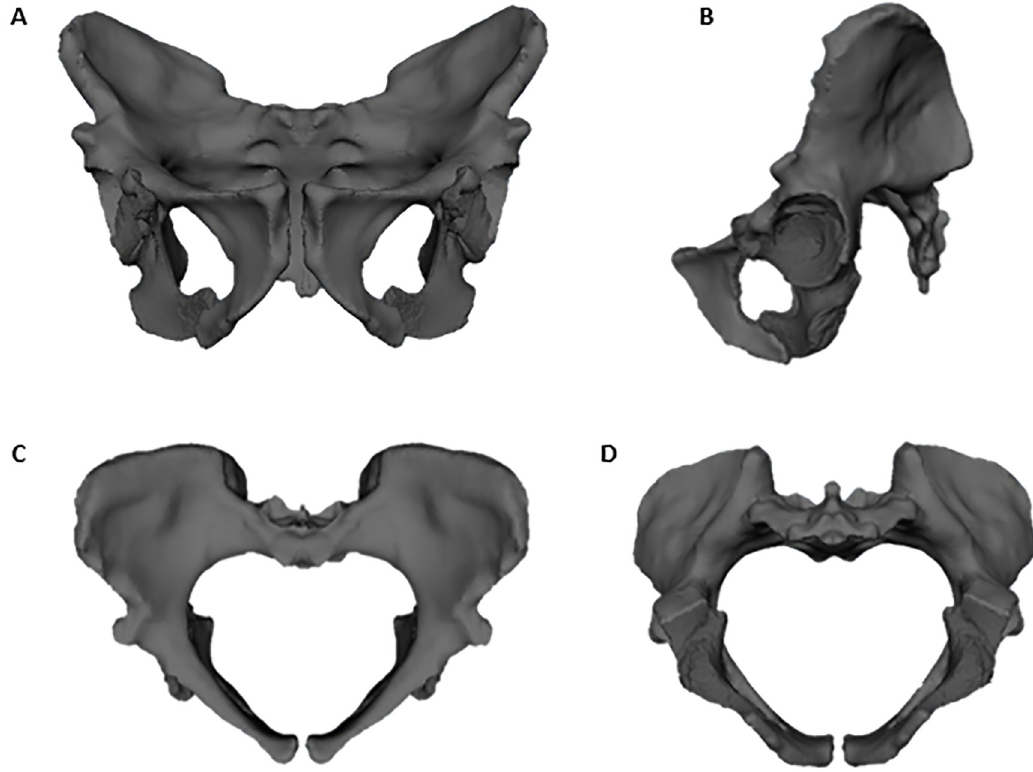
Fig 1. Full pelvis reconstruction of Australopithecus sediba using the ischium from MH1. The MH2 hemipelvis was mirror- imaged for the reconstruction. Composite pelvis shown in (A-D) anterior, lateral, superior, and inferior views. Notice that although the MH1 and MH2 acetabulae align, the ischium from MH1 does not cleanly conjoin with the inferior pubis ramus of MH2. This is likely a product of both sex and age differences between MH1 and